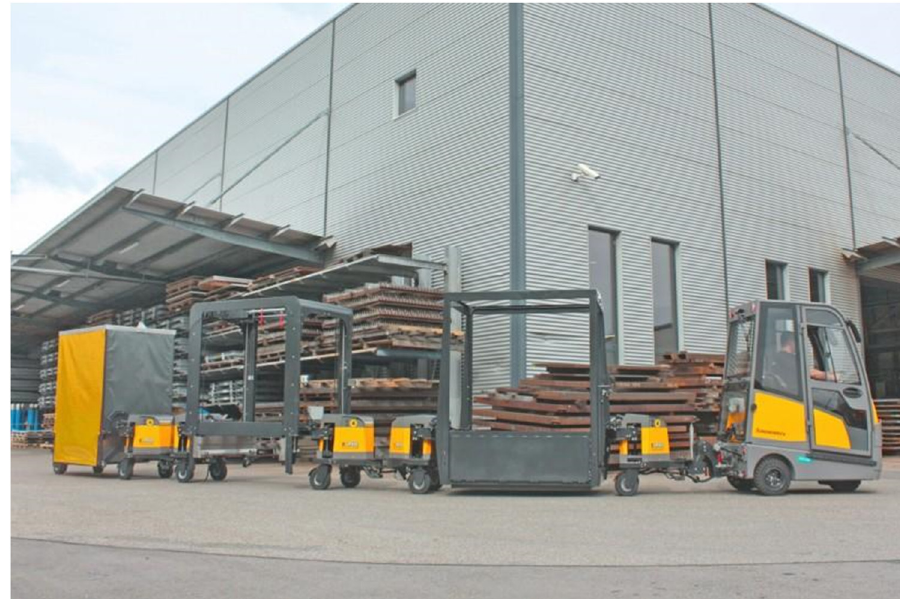
Figure 1: Example of a logistics train used in intralogistics [ 16 ]